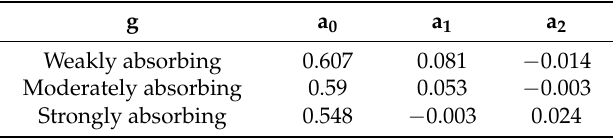
Table 12. The polynomial coefficients for the asymmetry